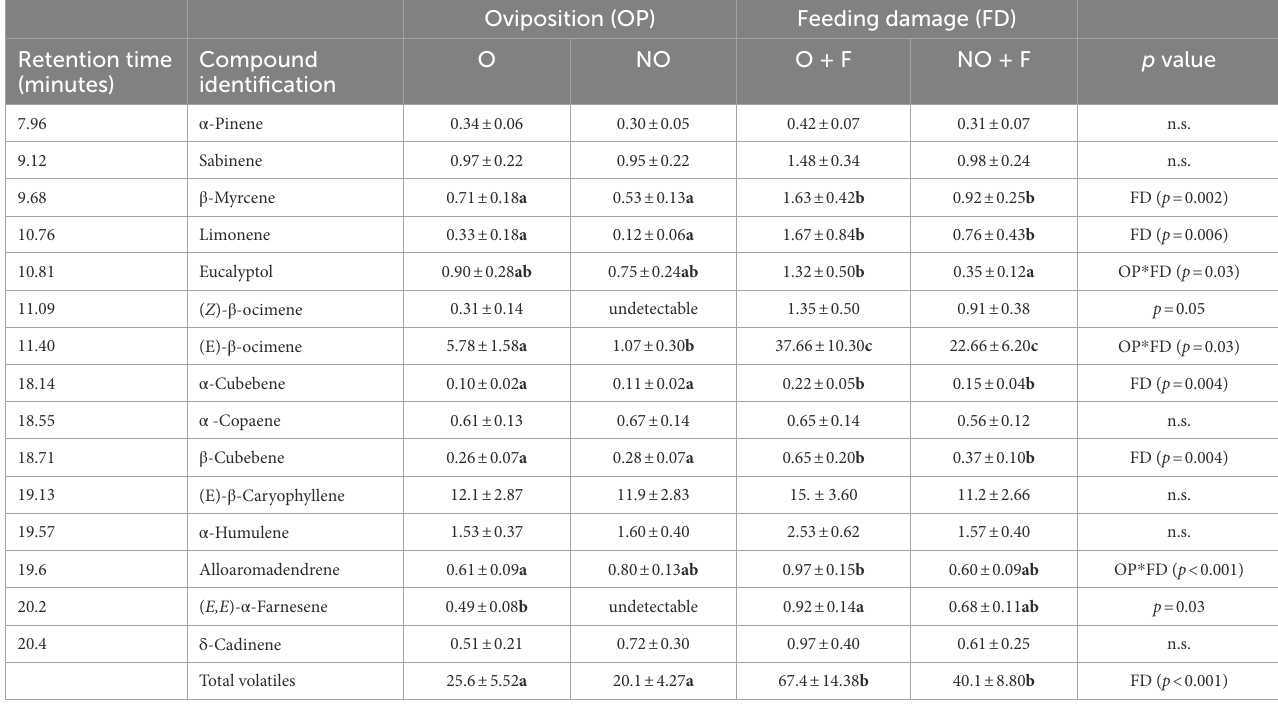
TABLE 1 The effect of N. oligospilus feeding and oviposition on volatile emission from S. babylonica . Oviposition (OP) Feeding damage (FD)